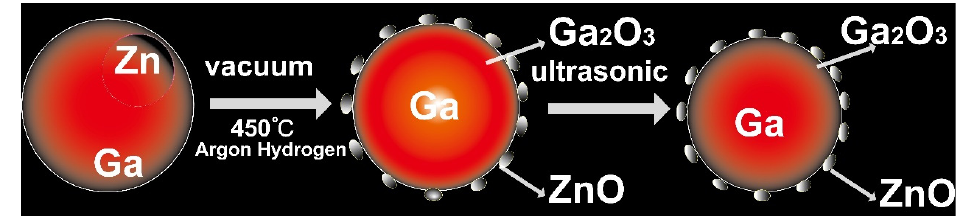
Figure 1. Synthesis schematic of the Ga 2 O 3 /ZnO composite.